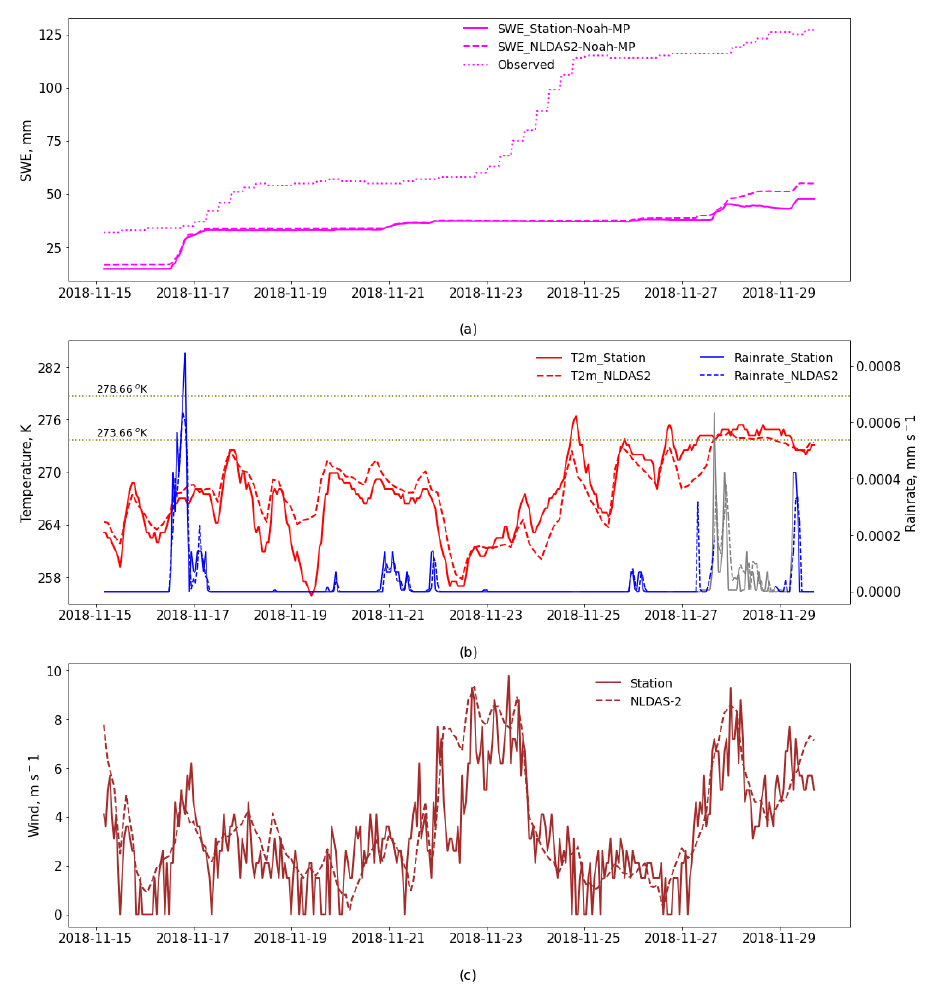
Figure 8. ( a ) Snow Water Equivalent; ( b ) T2m and Rain-rate (blue color indicates snowfall, gray color indicates mixed precipitation, and red color indicates rain (not in this plot)); ( c ) Wind Speed, in 15 − 29 November 2018.